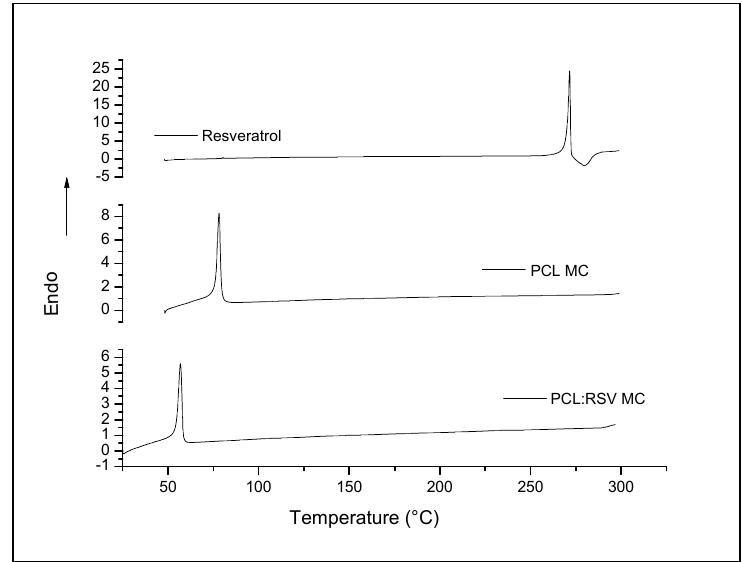
Figure 4. DSC curves obtained from pure RSV, empty micro capsules, and PCL microcapsules containing RSV.